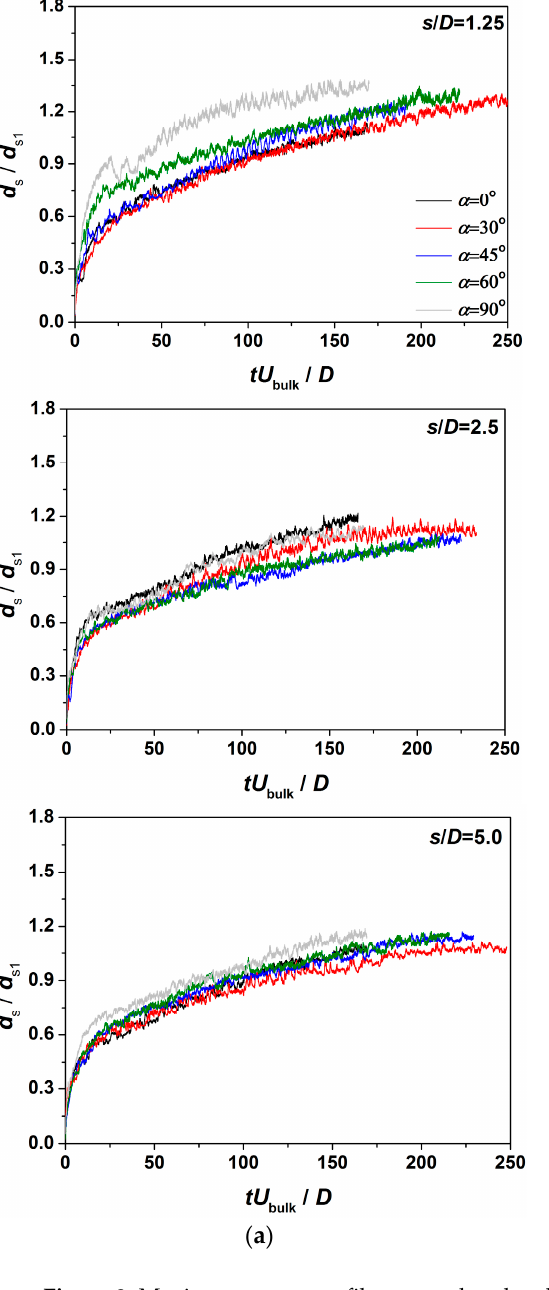
Figure 8. Maximum scour profiles around each cylinder for s / D = 1.25 ( Upper ), s / D = 2.5 ( Middle ), s / D = 5.0 ( Lower ): ( a ) Front cylinder; ( b ) Rear cylinder.